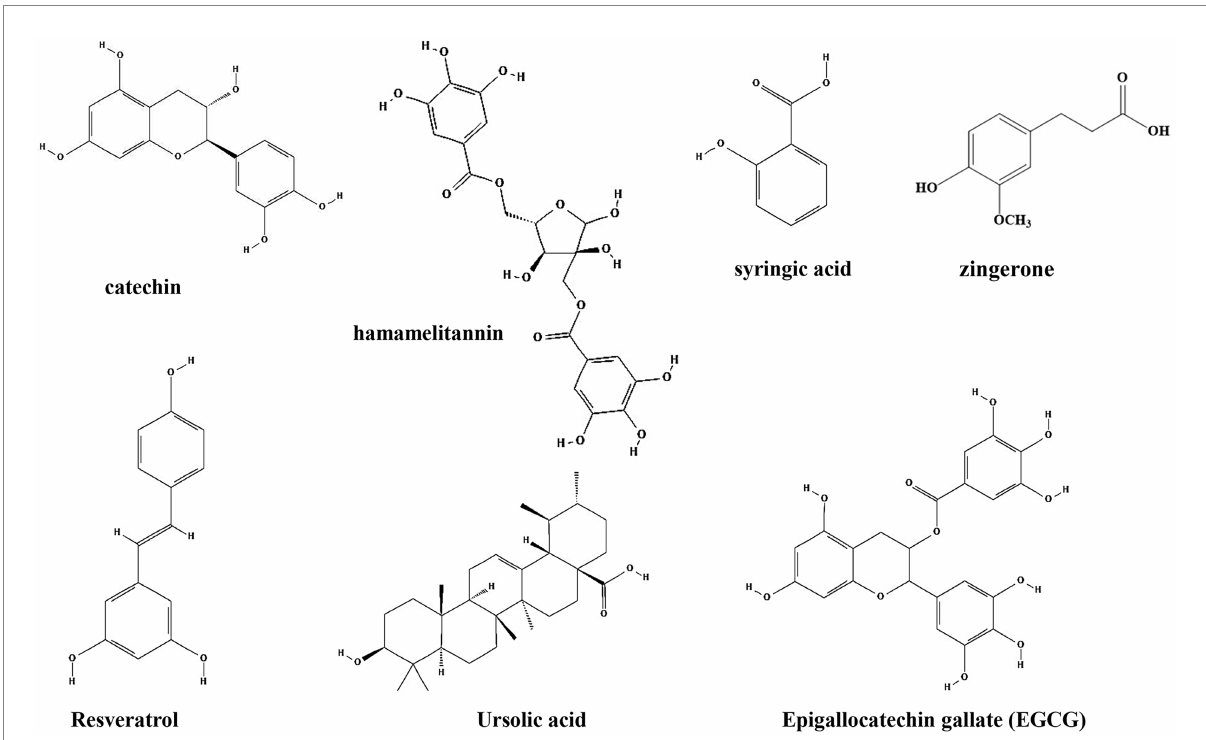
FIGURE 4 Chemical structures of the different phenols that inhibit biofilm formation via QS. ChemDraw software has been utilized to draw the chemical structures of the